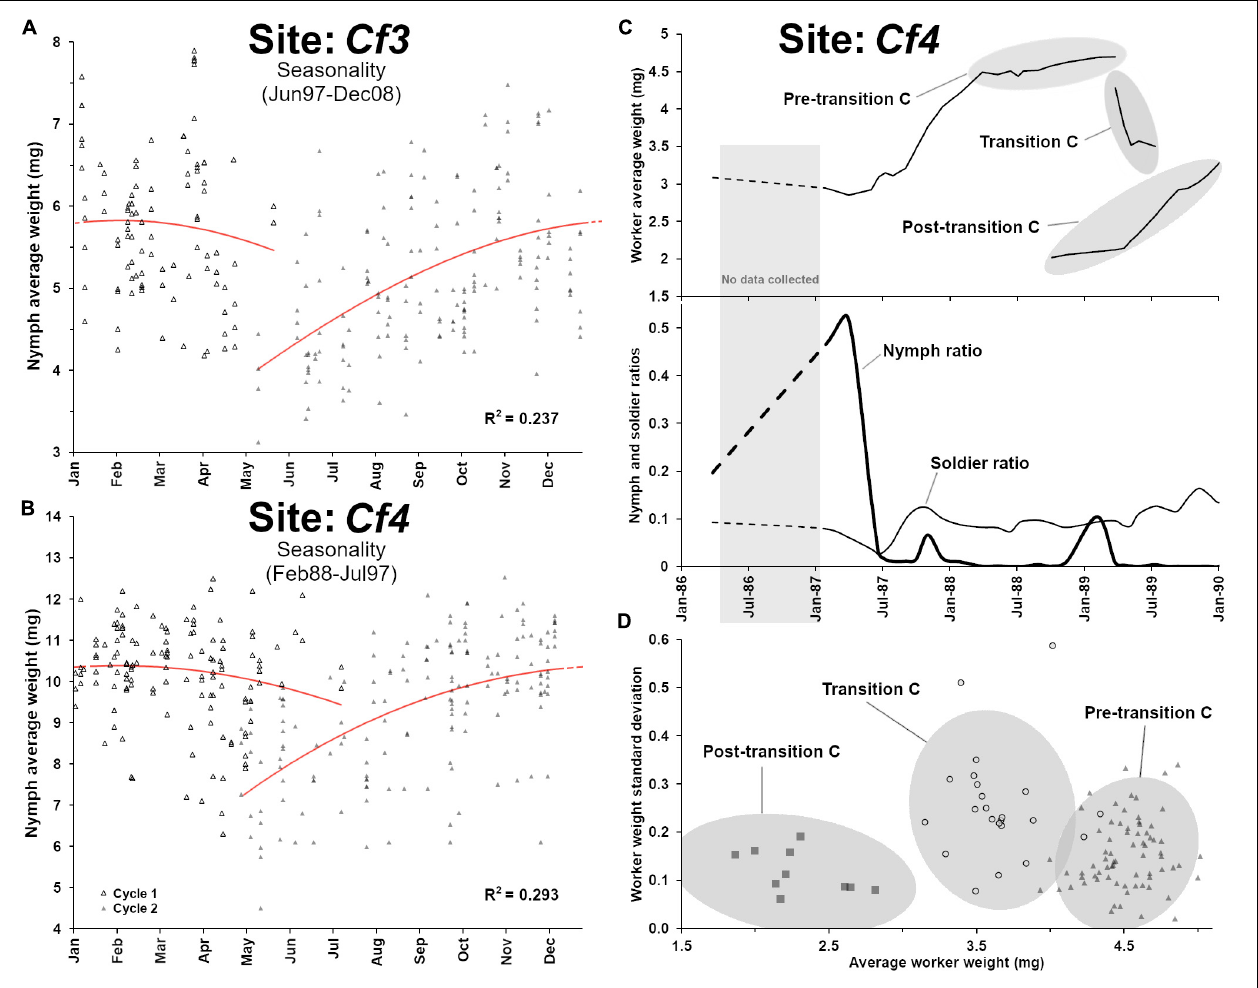
FIGURE 6 | Additional demographic analyses from site Cf3 and site Cf4 . (A) Nymphs’ average weight seasonality from Cf3 , with an annual growth that follows a polynomial function ( poly3 , F 3 , 263 = 27.3, p < 0.001, R 2 = 0.237). (B) Nymphs’ average weight seasonality Cf4 , with an annual growth that follows a polynomial function ( poly3 , F 3 , 302 = 41.8, p < 0.001, R 2 = 0.293). (C) Details of the demographic “transition C” from Cf4 , showing a high nymph ratio event prior to the senescence of the colony (pre-transition C). (D) Weight heterogeneity among worker groups (with 95% ellipses) during transition C, (heterogeneity = 0.25 ± 0.11a) was higher than pre-transition C (0.15 ± 0.07b) and post-transition C (0.11 ± 0.05b) (ANOVA, Tukey post hoc , α = 0.05), suggesting a temporary colony fusion process with a young neighboring colony, during the colony senescence of the initial colony at site Cf4